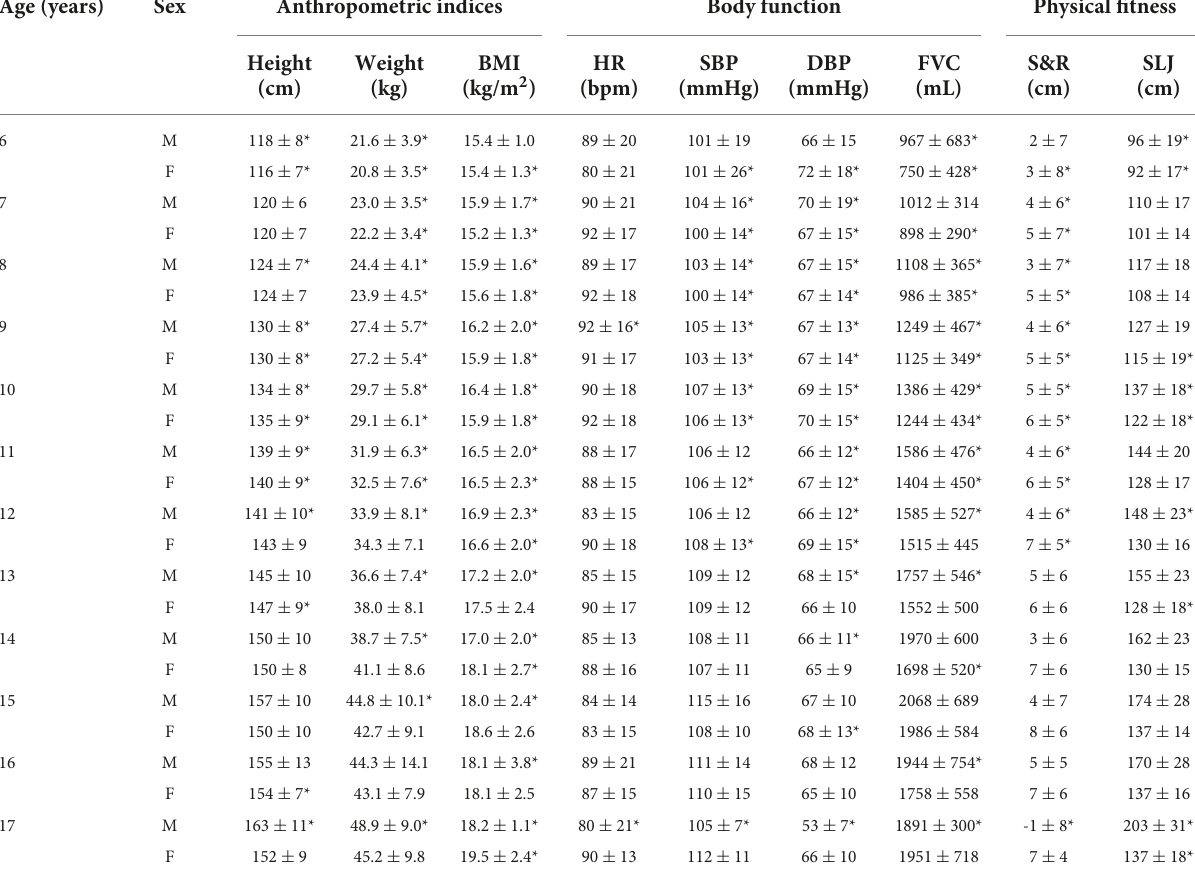
TABLE 2 Mean ± standard deviation of measurements in Tibet ethnic children aged 6–17. Age